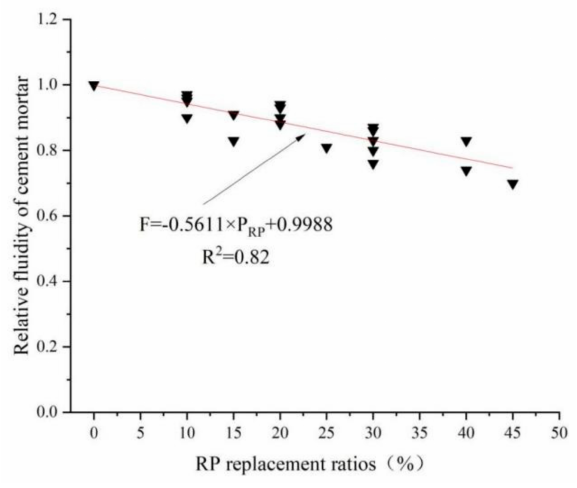
Figure 16. The relative fluidity of cement mortar under different replacement rates of RP [44,47,52,67,68,76].